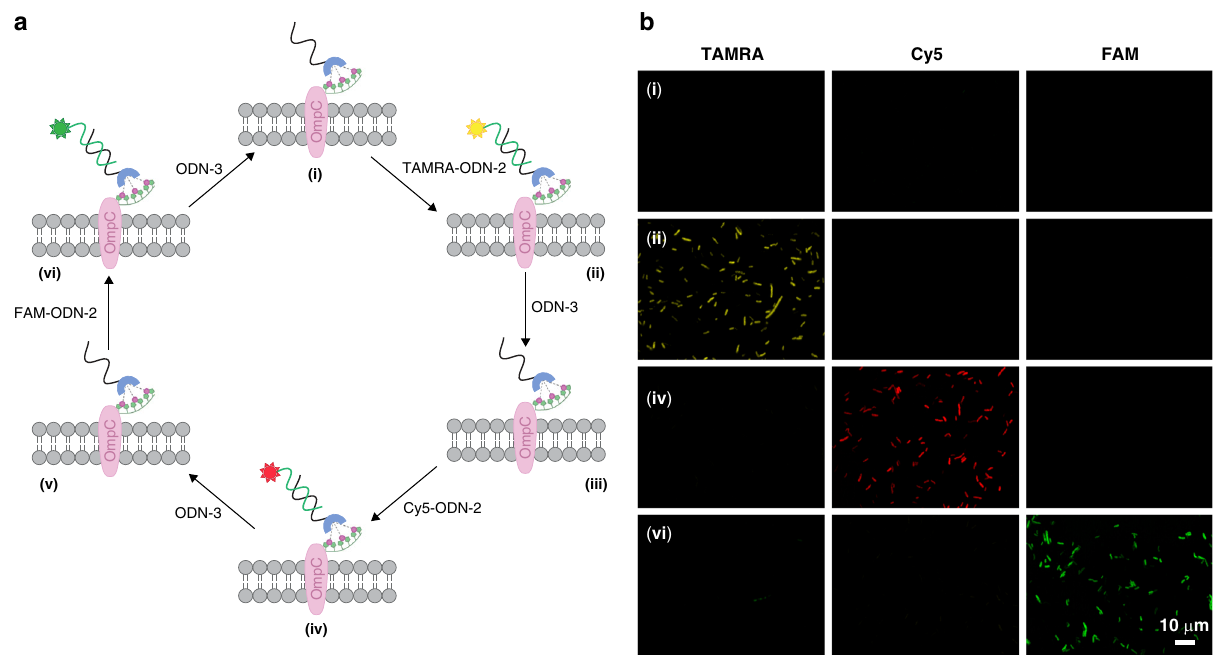
Fig. 3 Reversible modi fi cation of synthetic receptors bound to the bacterial membrane. a A synthetic receptor bound to the His-tagged bacteria (ODN-1) can be sequentially modi fi ed with unnatural functionalities, here, fl uorescent dyes (TAMRA, Cy5, or FAM), simply by incubating the modi fi ed bacteria with a dye-modi fi ed ODN-2 that can be selectively removed using ODN-3. b Monitoring states i, ii, iv, and vi in the sequential labeling process (the scheme on the left) by simultaneously observing the emissions of TAMRA, Cy5, and